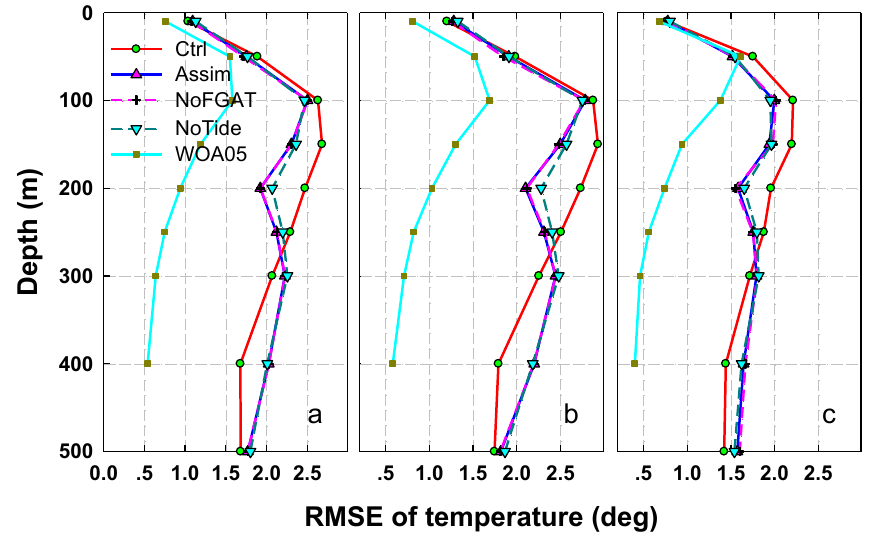
Fig. 14 Fig. 14. Comparison of the temperature RMSE profiles in Ctrl, Assim, NoFGAT, and NoTide with the EN3 temperature profiles in the 8 months during 1994–1995. RMSE for World of Atlas 2005 climatology is added as reference. Statistics are computed on the full SCS (a) , the Northern SCS (b) and the Southern SCS (c) of 13 ◦ N latitude.